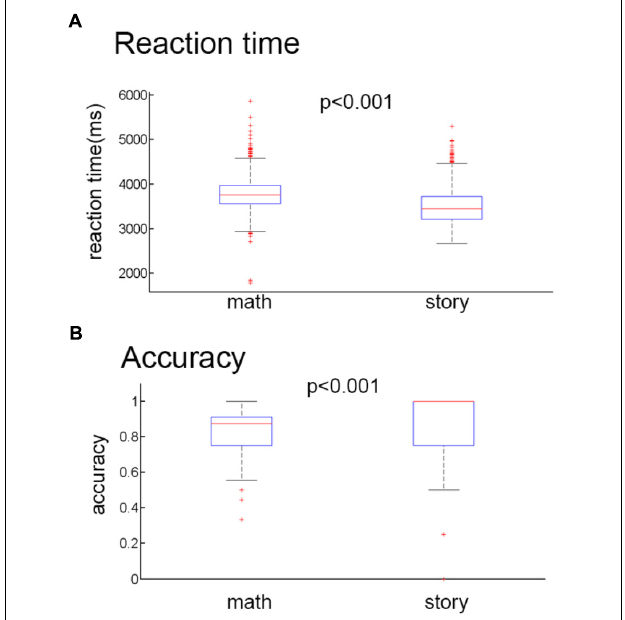
FIGURE 2 | Behavioral results. (A) Mean reaction time for the math stimuli and story stimuli. (B) Mean accuracy rates for the math stimuli and story stimuli.